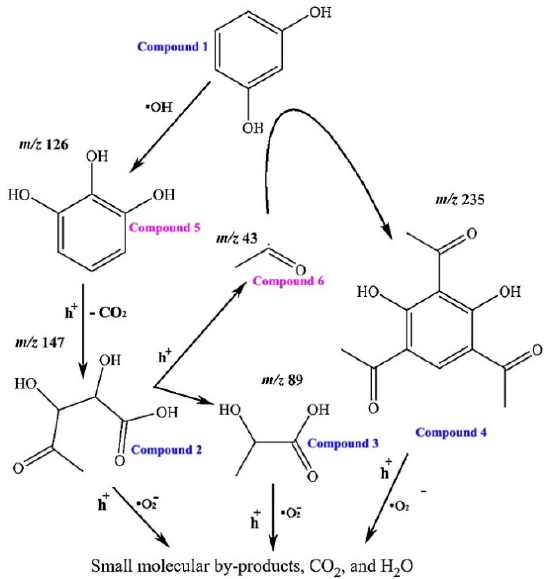
Figure 13. Proposed photocatalytic mechanisms of resorcinol given exposure to Bi 4 O 5 Br x I 2 − x and visible light [116]. Copyright Elsevier 2018.